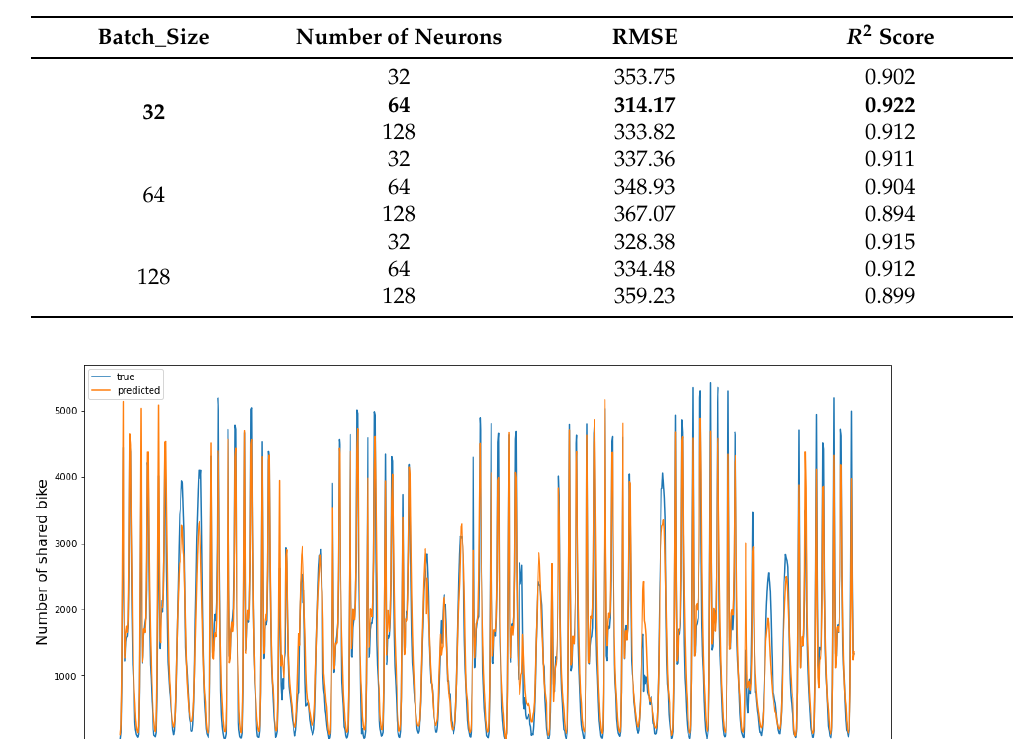
Table 4. Experimental results (time_step = 24).